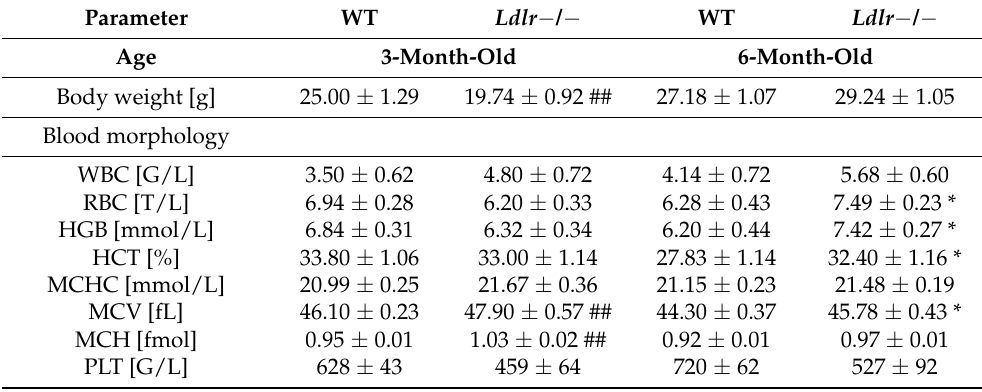
Table 2. Blood morphology in dyslipidemic Ldlr − / − mice. Body weight and blood morphology pa- rameters in 3-month-old and 6-month-old wild-type (WT) and dyslipidemic mice (Ldlr − / − ), n = 10; * p < 0.05 vs. 6-month-old WT, ## p < 0.01 vs. 3-month-old WT. Parameter WT Ldlr − / − WT Ldlr − / − Age 3-Month-Old Body weight